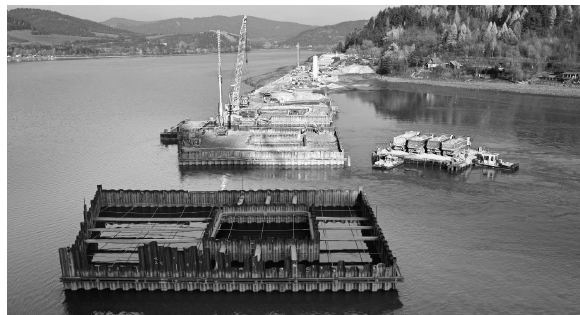
Figure 6. A heavy stone